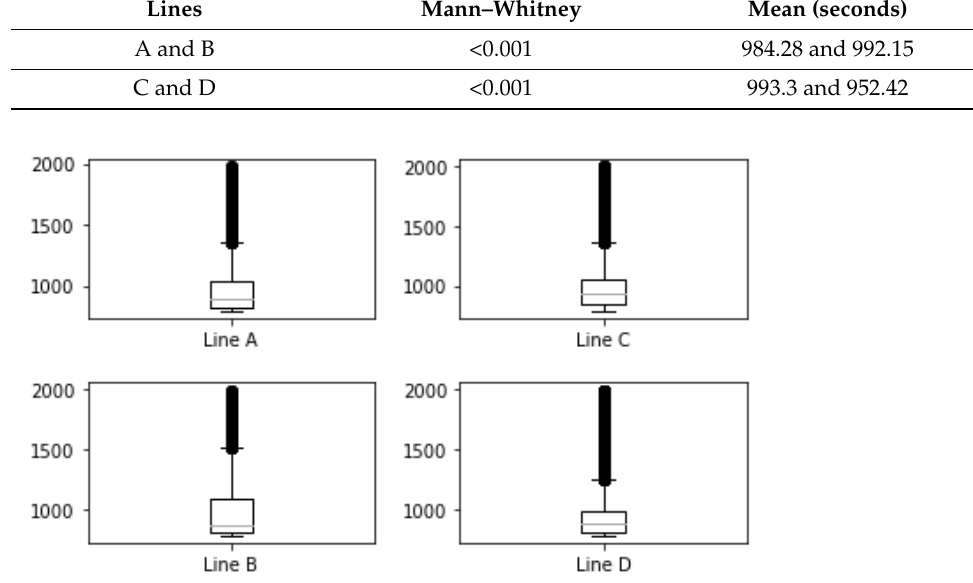
Figure 3. Boxplot for the cycle time (in seconds), per line.